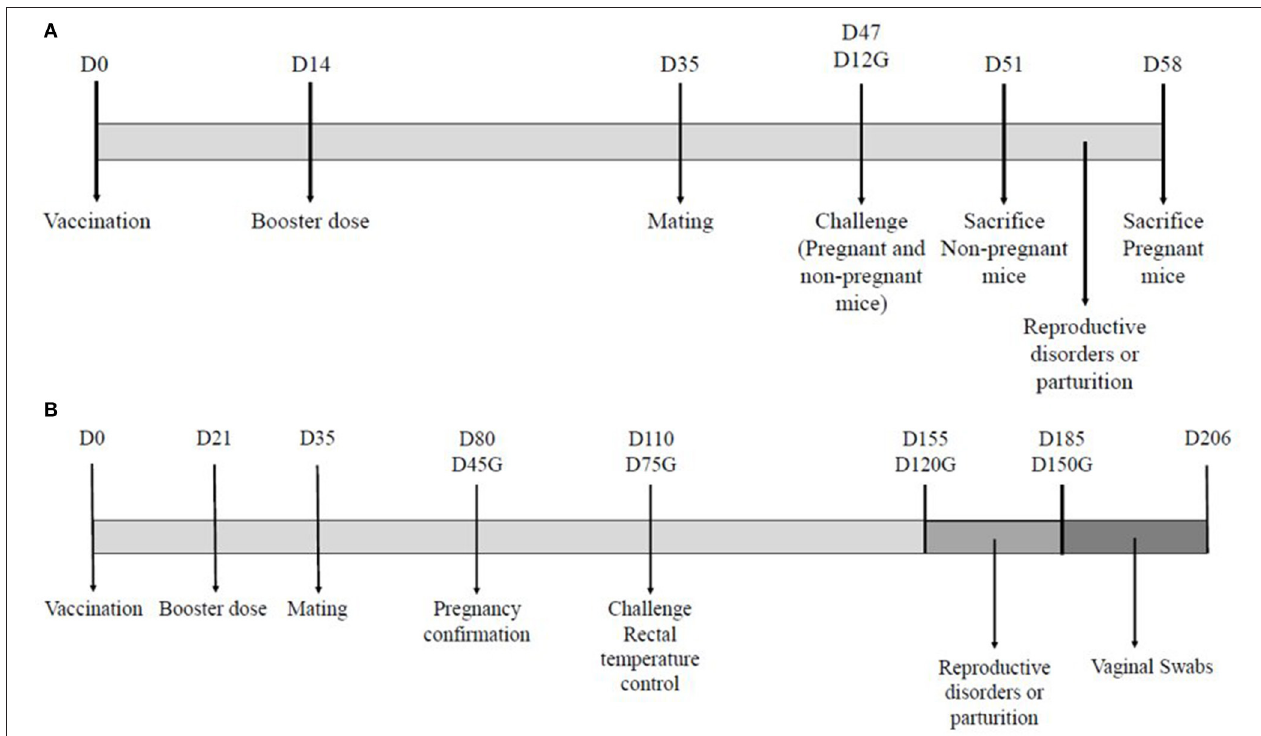
FIGURE 1 | Experimental designs for the mouse model (A) and the ovine model (B) . The diagrams illustrate the days (D) of the different interventions on the animals used in both experiments. The day of gestation is indicated for pregnant animals